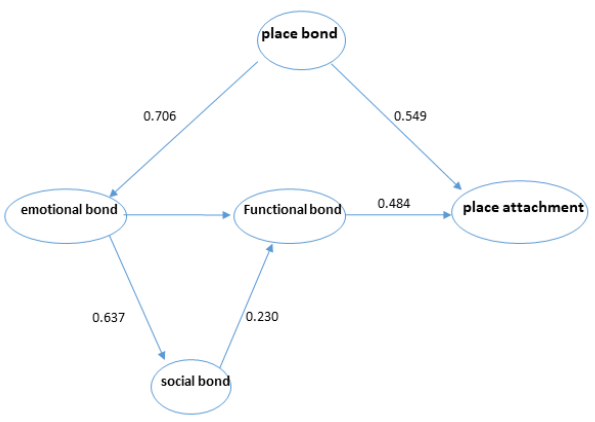
Figure 3. Model structure path coefficients.